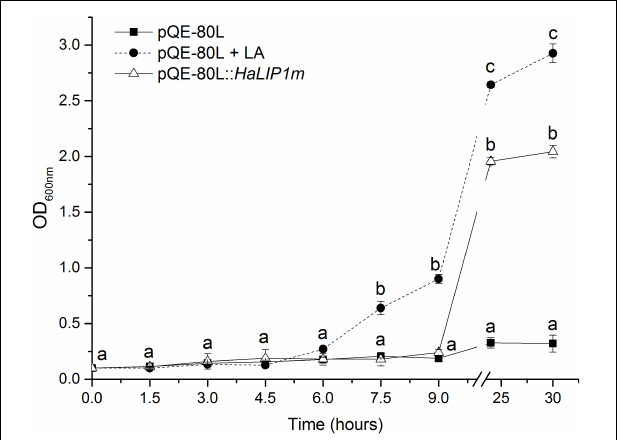
FIGURE 8 | Complementation of LipA-deficient JW0623 E. coli in M9 glucose minimal medium following transformation with HaLIP1m in a pQE-80L expression vector, and using E. coli cells transformed with the empty pQE-80L vector as a control: LA, lipoic acid supplementation (50 ng/mL). All cultures were induced with 0.5 mM IPTG and the break in the graph separates the growth during the first 9 h from the measurements at 24 and 30 h. The data represent the mean ± SD of three independent replicates and the different letters are the mean statistical differences ( p < 0.05) at each time point.